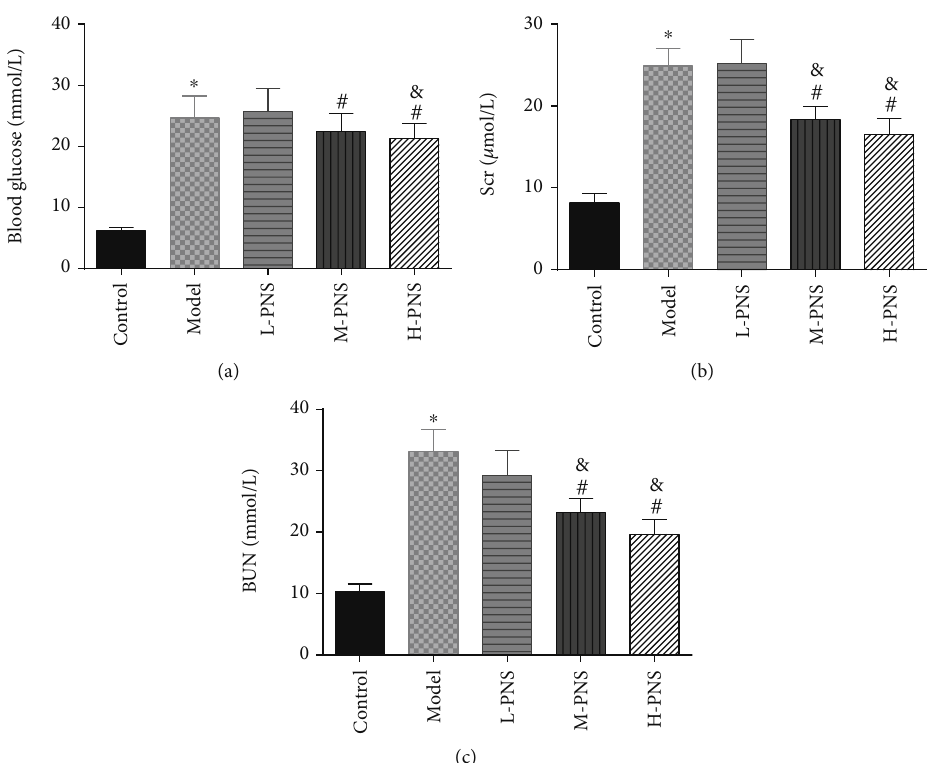
Figure 2: Detection of blood biochemical indices in mice ((a) blood glucose level. (b) Blood creatinine level. (c) Blood urea nitrogen level; ∗ P < 0 : 05 vs. control; # P < 0 : 05 vs. model; & P < 0 : 05 vs.